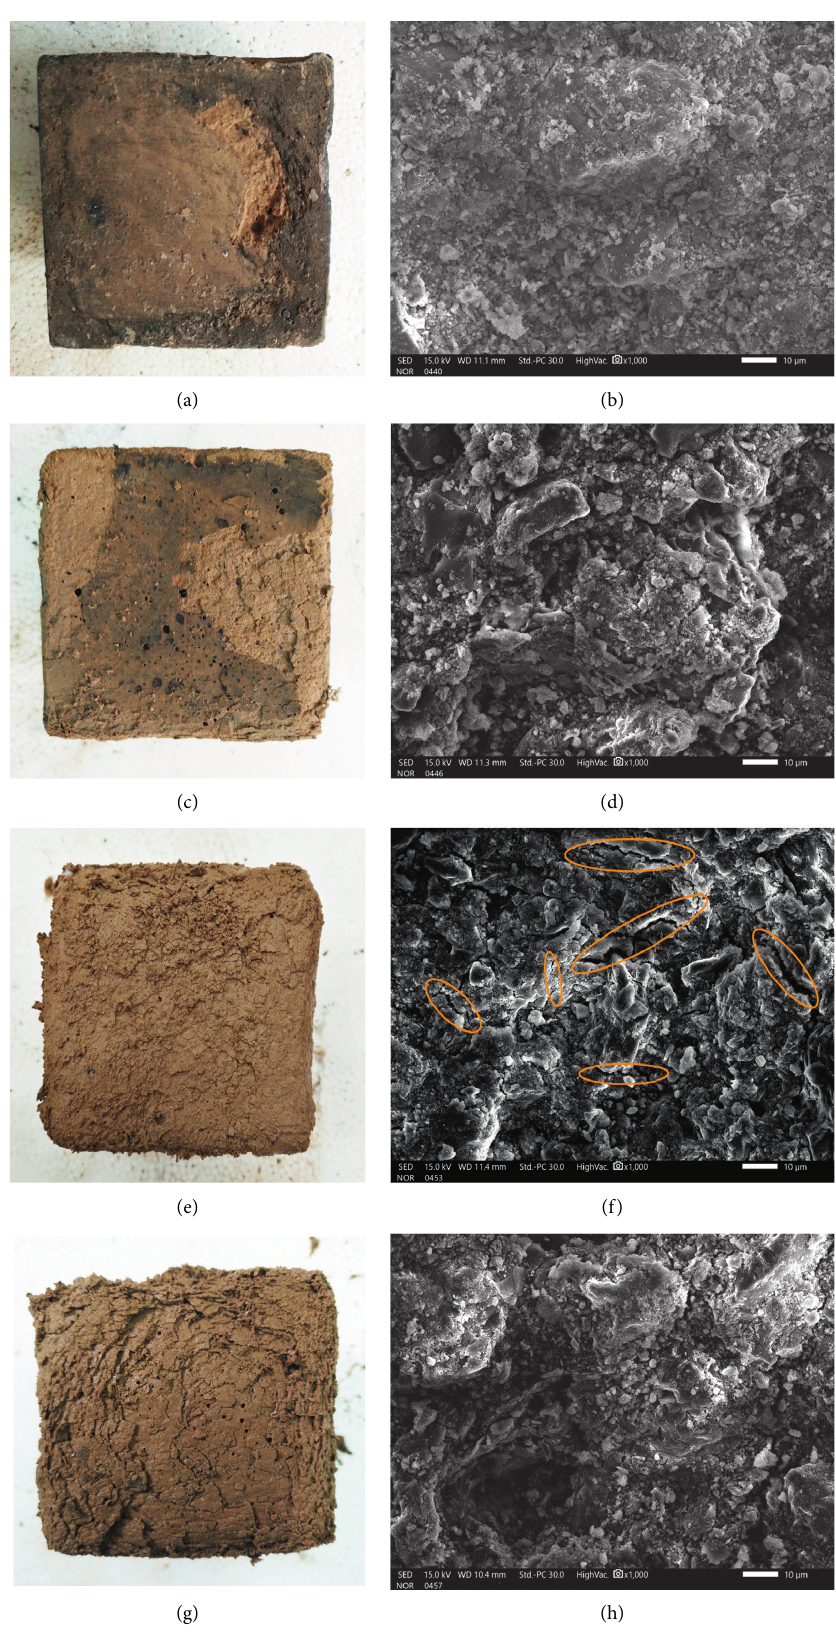
Figure 13: SEM images and corresponding photographs of RMCC under different freezing-thawing cycles ( C FTC � 3, (e) FTC � 5, and (g) FTC � 7. The magnification of (b), (d), (f), and (h) is